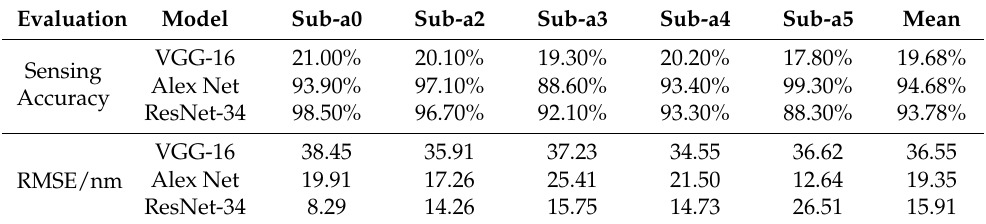
Table 3. The test results of the five sub-apertures based on different networks.